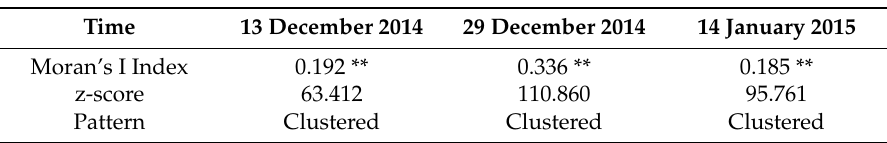
Pattern Clustered Clustered Clustered Note: p < 0.001 in all regions in 2014 and 2015; ** represents significant values.